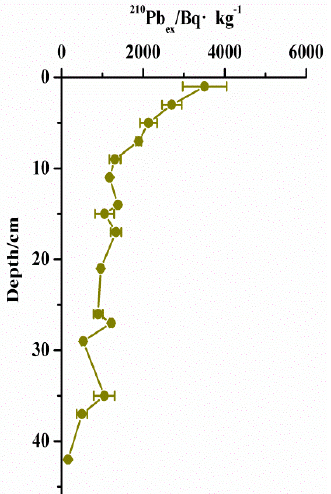
Figure 3. Vertical profiles of 210 Pb ex in Lake Taihu.